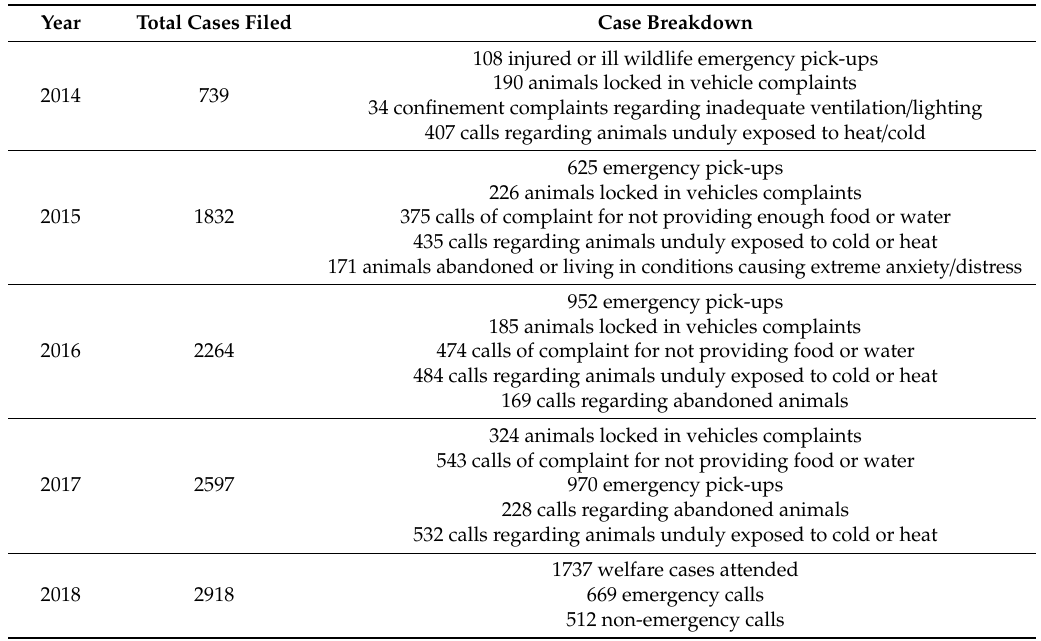
Table 4. Winnipeg Humane Society Animal Cruelty Statistics between 2014 and 2018.